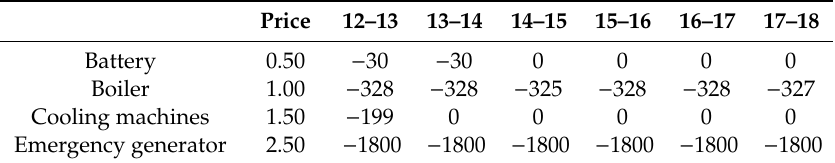
Table 7. Bids for iteration 1.